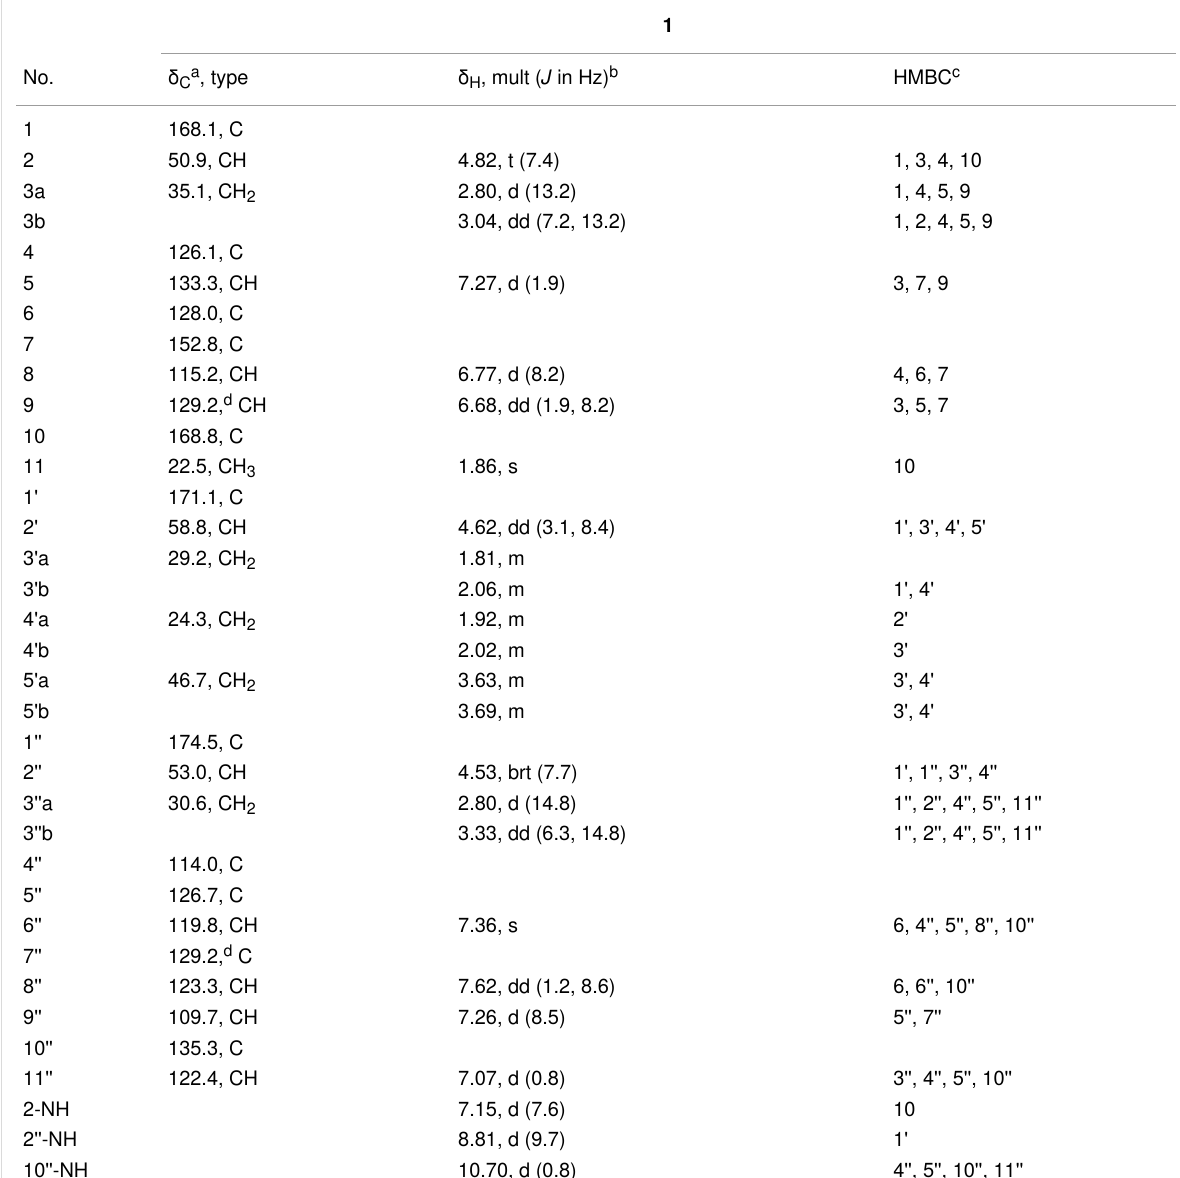
Table 1: NMR spectroscopic data for pseudosporamide ( 1 ) in DMSO- d 6